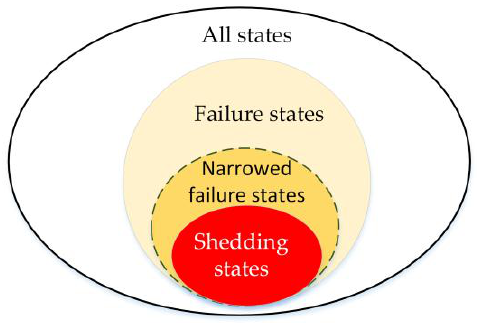
Figure 5. Venn diagram of grid states.